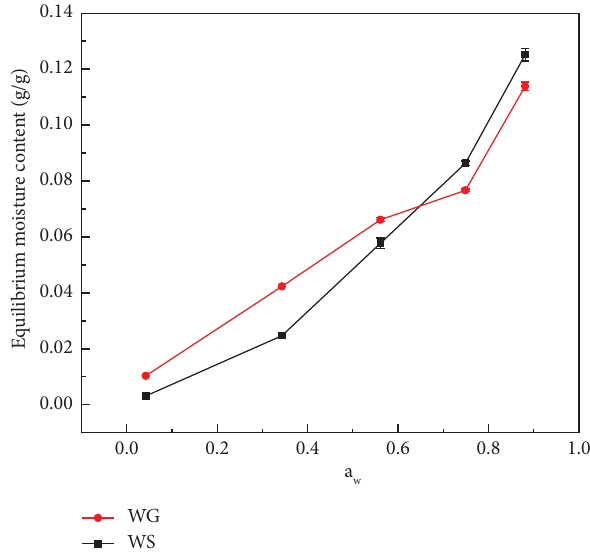
Figure 1: Moisture adsorption isotherms for WS and WG. WS and WG represent wheat starch and wheat gluten,